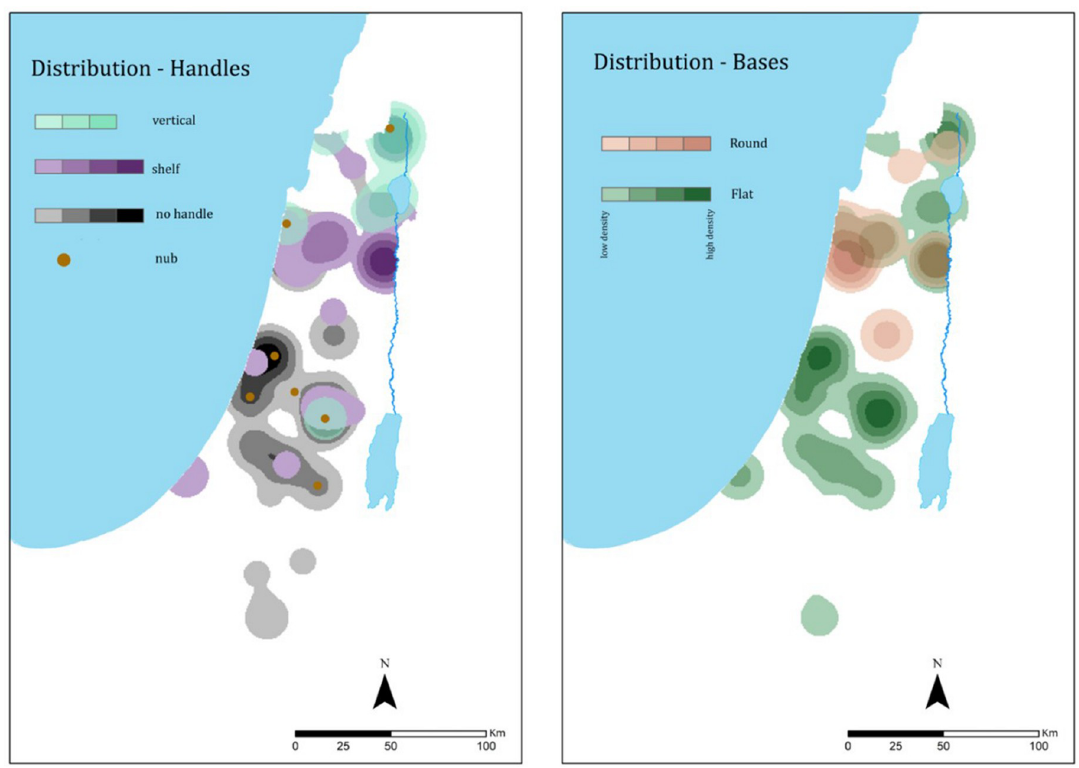
Fig 7. Density maps with ARCMAP showcasing the distribution of jars with handles (left) and different types of jar bases (right).